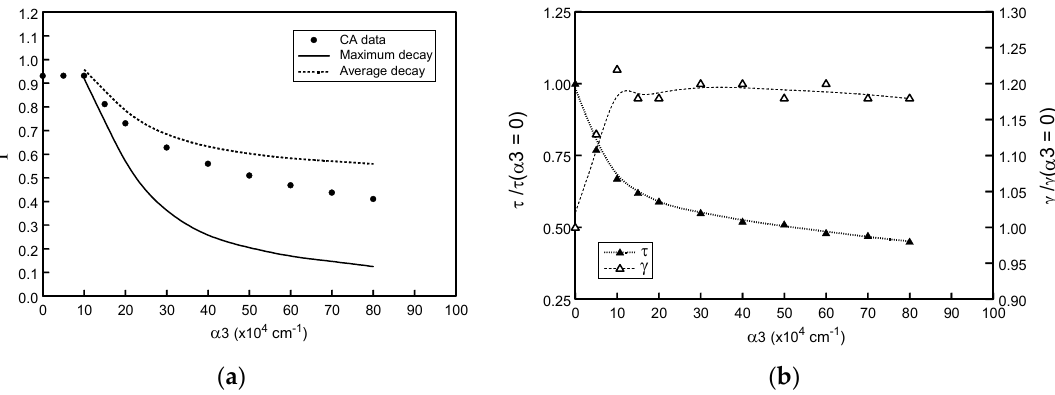
Figure 6. α 3 dependence of dynamical parameters (symbols) from CA data fitted using Equation (1): ( a ) Converted fraction Γ ; ( b ) Characteristic time constant τ and stretched-exponential parameter γ which are normalized to their α 3 = 0